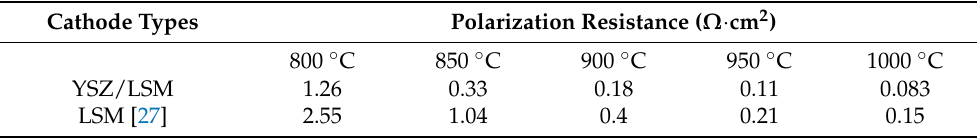
Table 2. Comparison of polarization properties of YSZ/LSM and LSM.